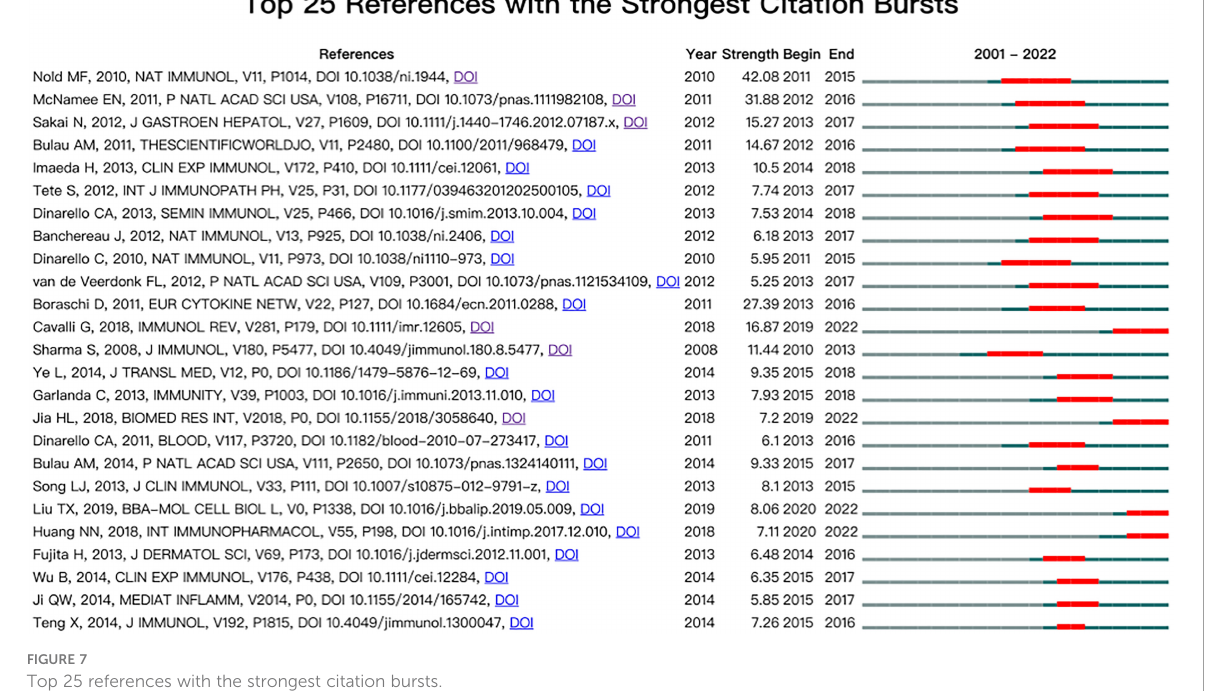
time. A total of 423 keywords were extracted, of which 57 keywords appeared more than 10 times. As demonstrated in Figure 8A and Table 6, “ IL-37 ” and “ expression ” were the most important terms with 165 co-occurrences, followed by “ in fl ammation ” , “ cytokine ” , “ IL-1 family ” , “ cell ” , and “ immunity ” . In addition, the centrality of “ IL-37 ” , “ in fl ammation ” , “ IL-1 family ” , “ receptor ” , “ NF- k B ” ,